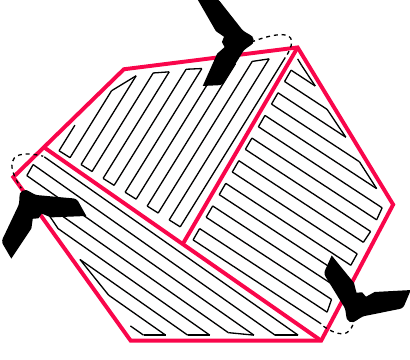
Figure 4. Example illustrating the method proposed in [22]. The area is decomposed using the robots autonomy and inside every cell the coverage pattern is optimized to decrease unnecessary